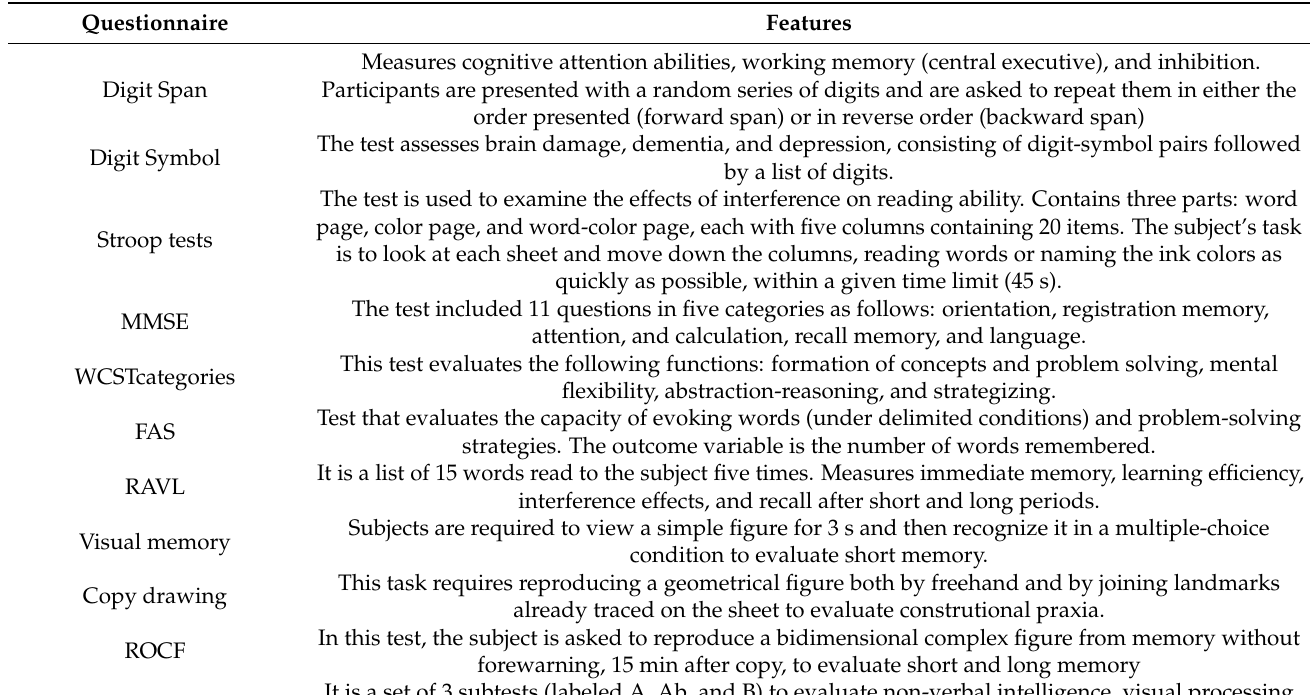
Table 2. Description of neurocognitive